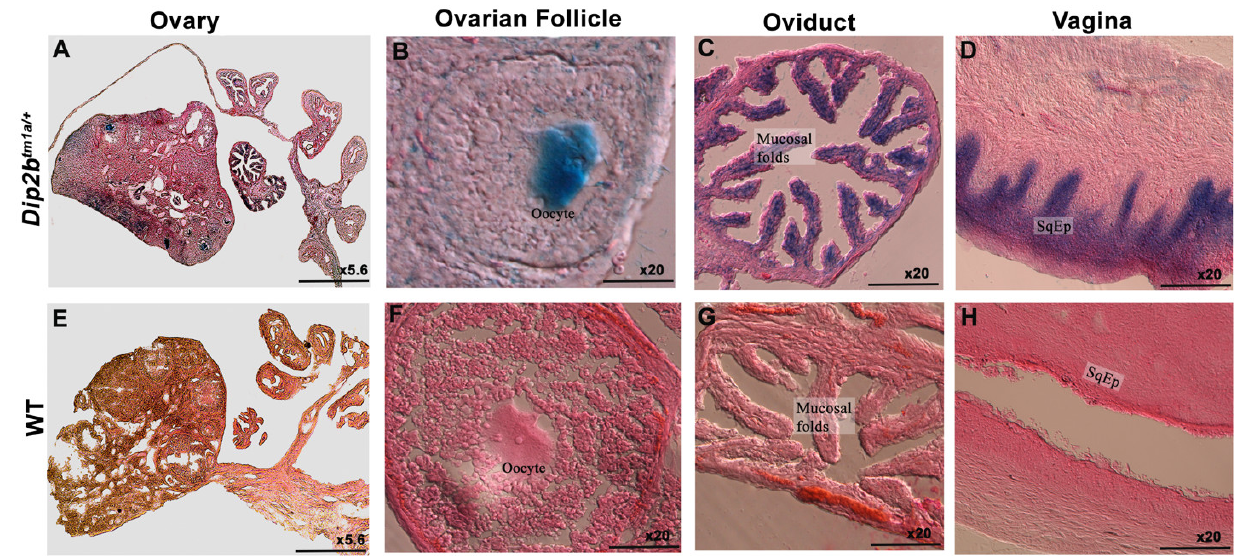
Figure 4. LacZ expression in the female reproductive system. ( A ) Cross-section of the ovary of a non-pregnant mouse. LacZ expression is visible in the ovarian follicles and oviduct. ( B , C ) High magnification of ovarian follicles and oviduct. ( D ) Section of the vagina with a LacZ signal at the stratified squamous epithelium (SqEp). ( E – H ) Wild-type littermate was LacZ-negative.